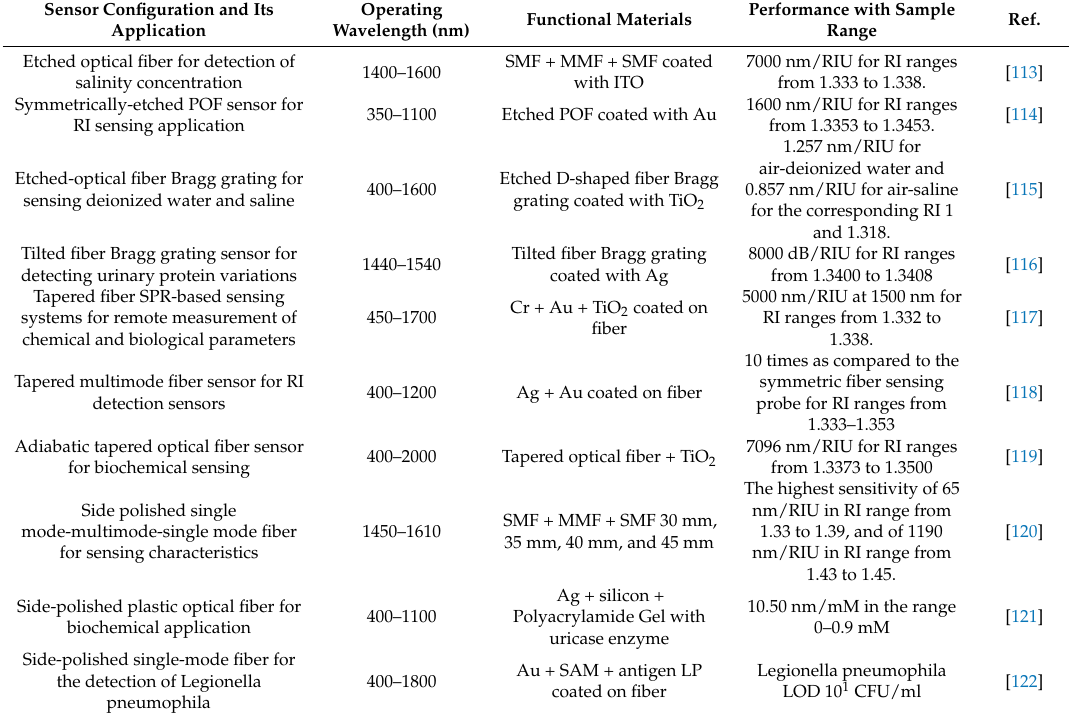
Table 1. Summary of selected experimental performances for fiber optic plasmonic probes. Performance with Sample Sensor Configuration and Its Operating Functional Materials Range Application Wavelength (nm)